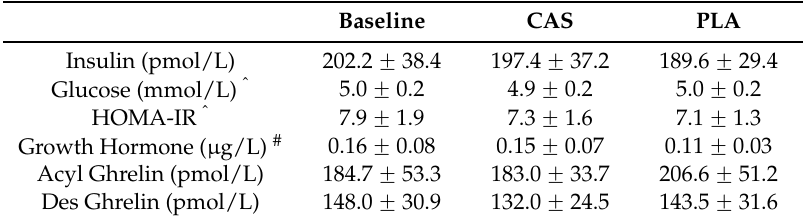
Table 3. Morning blood markers.